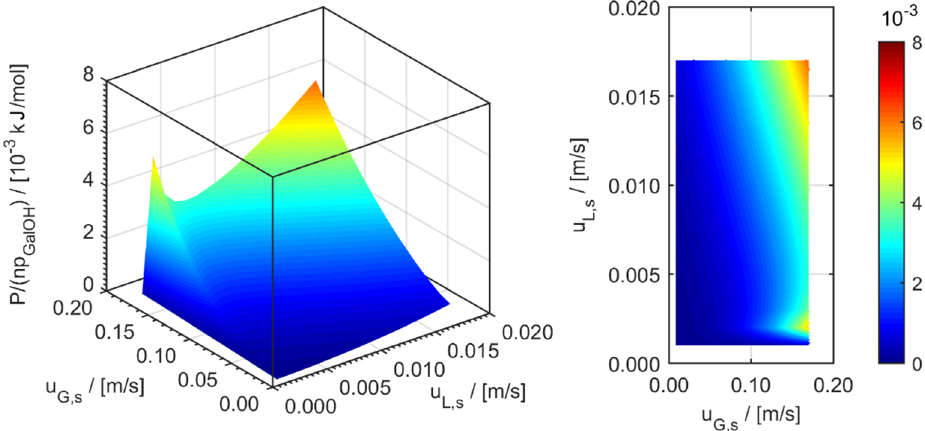
Figure 16. Specific energy consumption of foam-packed minichannel reactors operating at different gas and liquid superficial velocities.